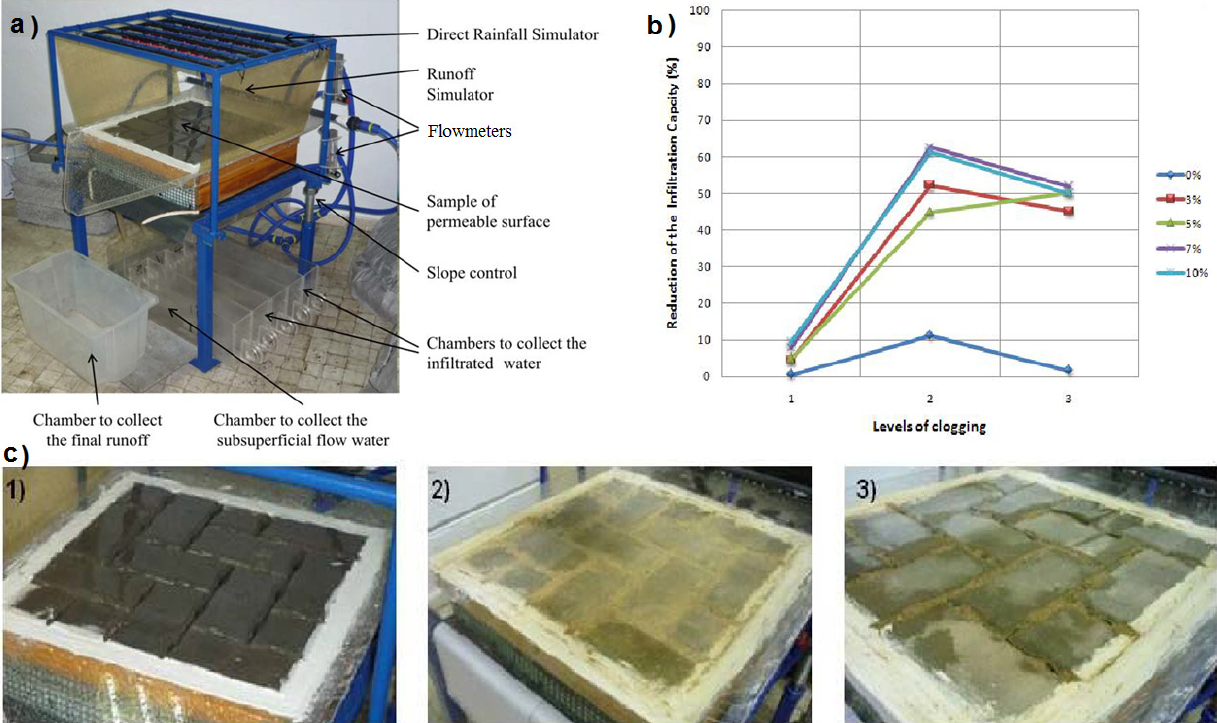
Figure 14. (a ) Improved Cantabrian Fixed Infiltrometer; ( b ) Infiltration capacity of ICBP surface for different slopes; ( c ) Different clogging conditions tested [53]: ( 1 ) No clogging, ( 2 ) Fully clogged surface and ( 3 ) Residual clogging after